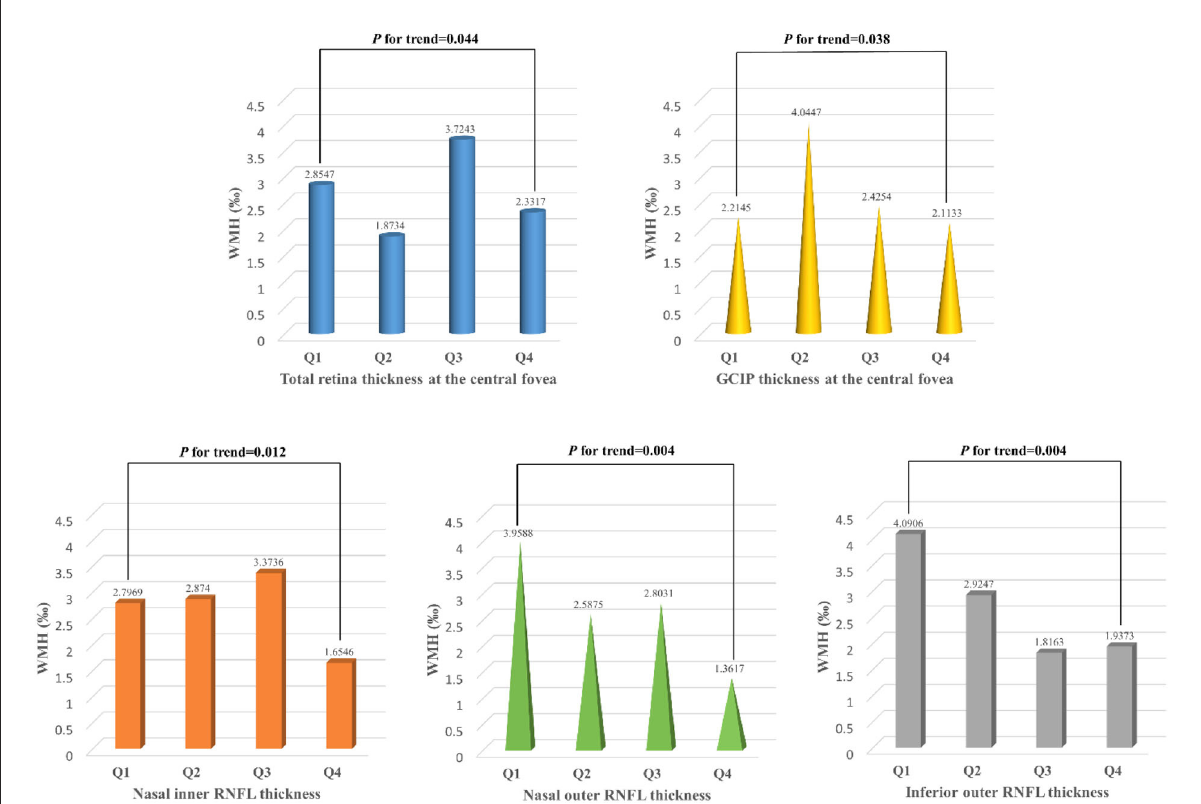
FIGURE4 White matter hyperintensity volume of participants with different quartiles of the total retina and GCIP thickness at the central fovea, nasal inner RNFL, nasal outer RNFL, and inferior outer RNFL thickness. WMH, white matter hyperintensity; RNFL, retinal nerve fiber layer; GCIP, ganglion cell and inner plexiform layer. Total retinal thickness ( P for trend = 0.044) and GCIP thickness ( P for trend = 0.038) at the central fovea were positively associated with the risk of higher WMH volume, while nasal inner RNFL ( P for trend = 0.012), nasal outer RNFL ( P for trend = 0.004), and inferior outer RNFL ( P for trend = 0.004) thickness were negatively associated with the risk of higher WMH